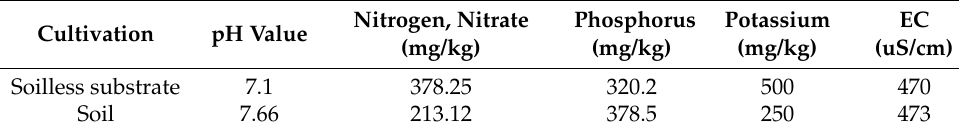
Table 1. Nutritional status, pH, and electrical conductivity of growth medium.